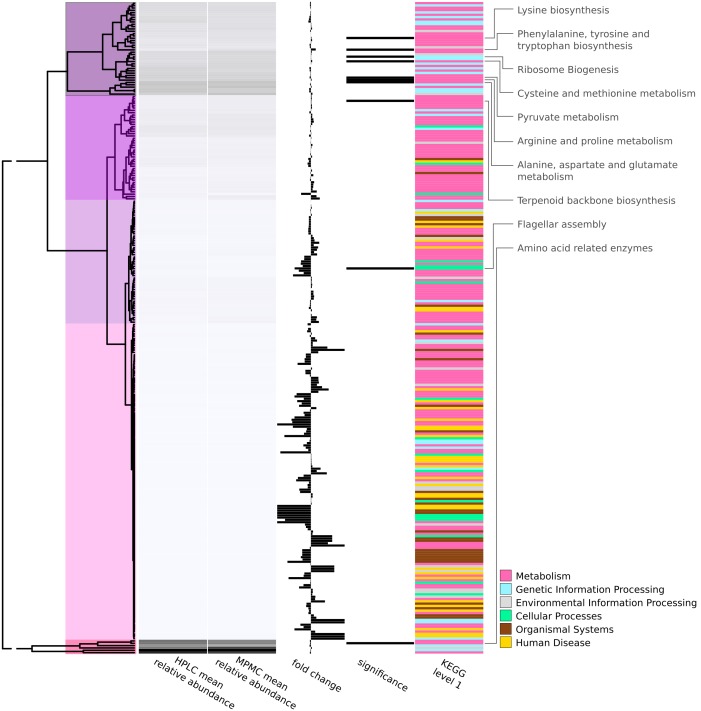
Functional profiles for 280 biochemical pathways (KEGG level 3).Pathways were clustered and sorted by their average relative abundance in the two diets. Cluster structure is indicated by colors overlaid onto the dendogram. Fold changes (full bar equals to a six fold change) to the left indicate a higher abundance in high protein diet (HPLC). The next column indicates ten pathways with an over-representation of ortholog groups (KEGG level 4) with significant diet differences. Six out of ten pathways (names given in right column) are related to amino acid metabolism highlighting the effect of differences in dietary protein on the microbiome.